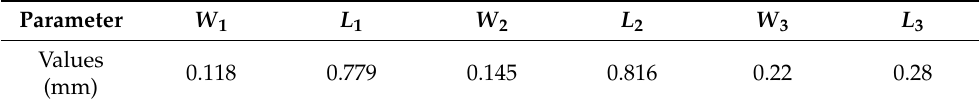
Figure 5. Layout of the 77 GHz microstrip 90 ◦ hybrid coupler in ADS. Table 4. Dimensions of the microstrip 90 ◦ hybrid coupler.